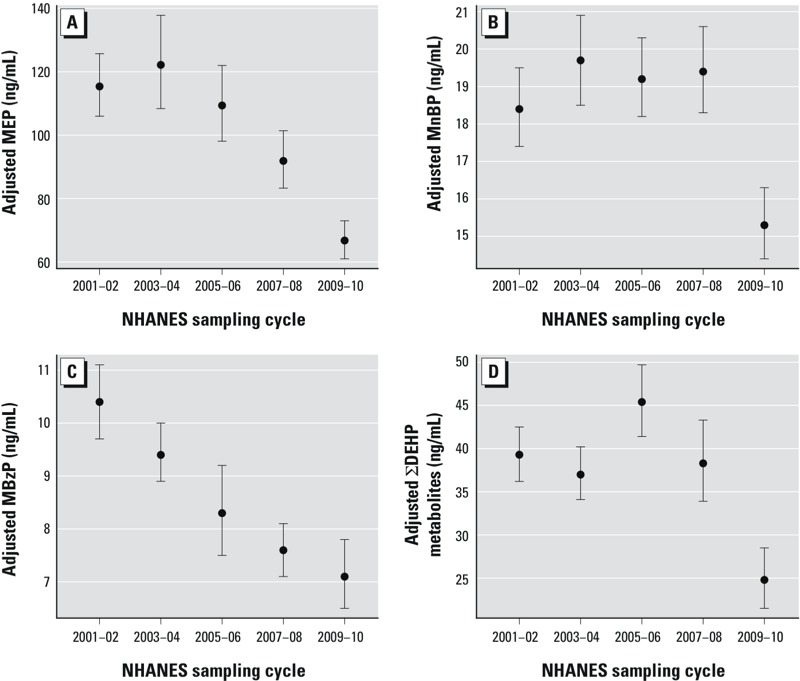
Association between phthalate metabolites and NHANES sampling cycle in the general U.S. population for (A) MEP (n = 11,071; parent phthalate = DEP) (p < 0.0001); (B) MnBP (n = 11,071; parent phthalate, DnBP; p < 0.0001); (C) MBzP (n = 11,071; parent phthalate, BBzP; p < 0.0001); and (D) ∑DEHP metabolites (n = 11,071; parent phthalate, DEHP; p < 0.0001). Models are adjusted for urinary creatinine. Data points represent LSGM and error bars represent 95% CIs. Corresponding numeric data are provided in Supplemental Material, Table S3. p-Value for the overall comparison between groups assessed by the Wald Test.